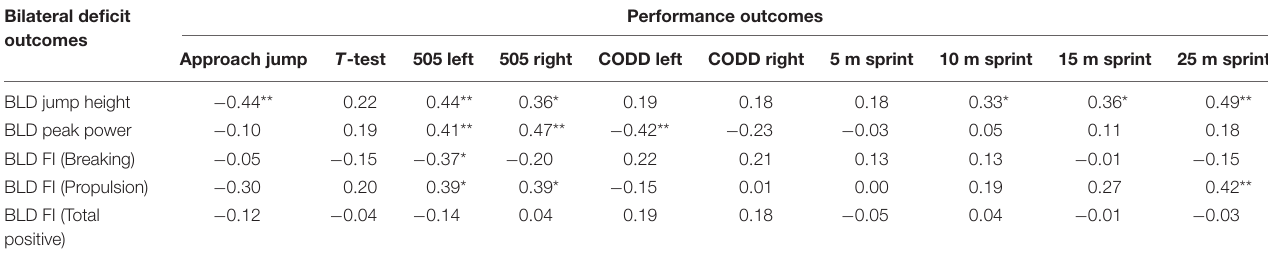
TABLE 3 | Correlations among BLD and performance measures. Bilateral deficit